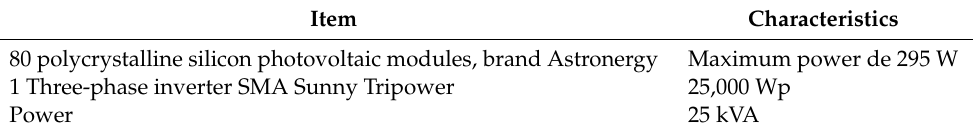
Table 5. Energetic requirement for on-grid plant. Development company of the photovoltaic plant [59]. Item